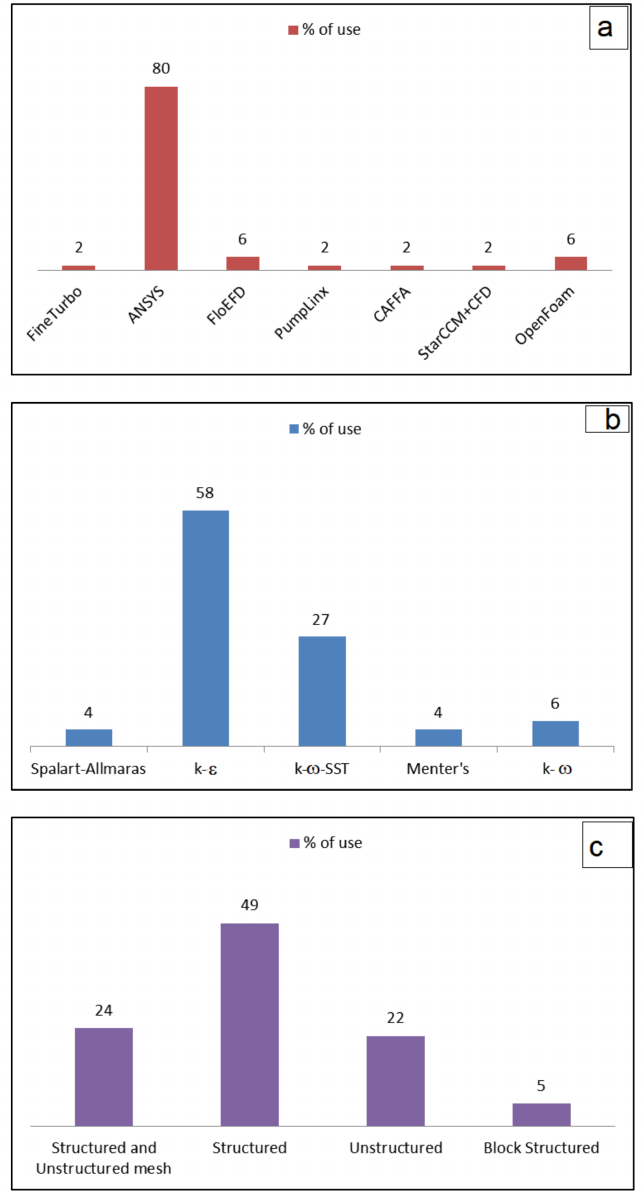
Figure 3. ( a ) CFD packages used in the published simulation; ( b ) Closure turbulence models, ( c ) Used